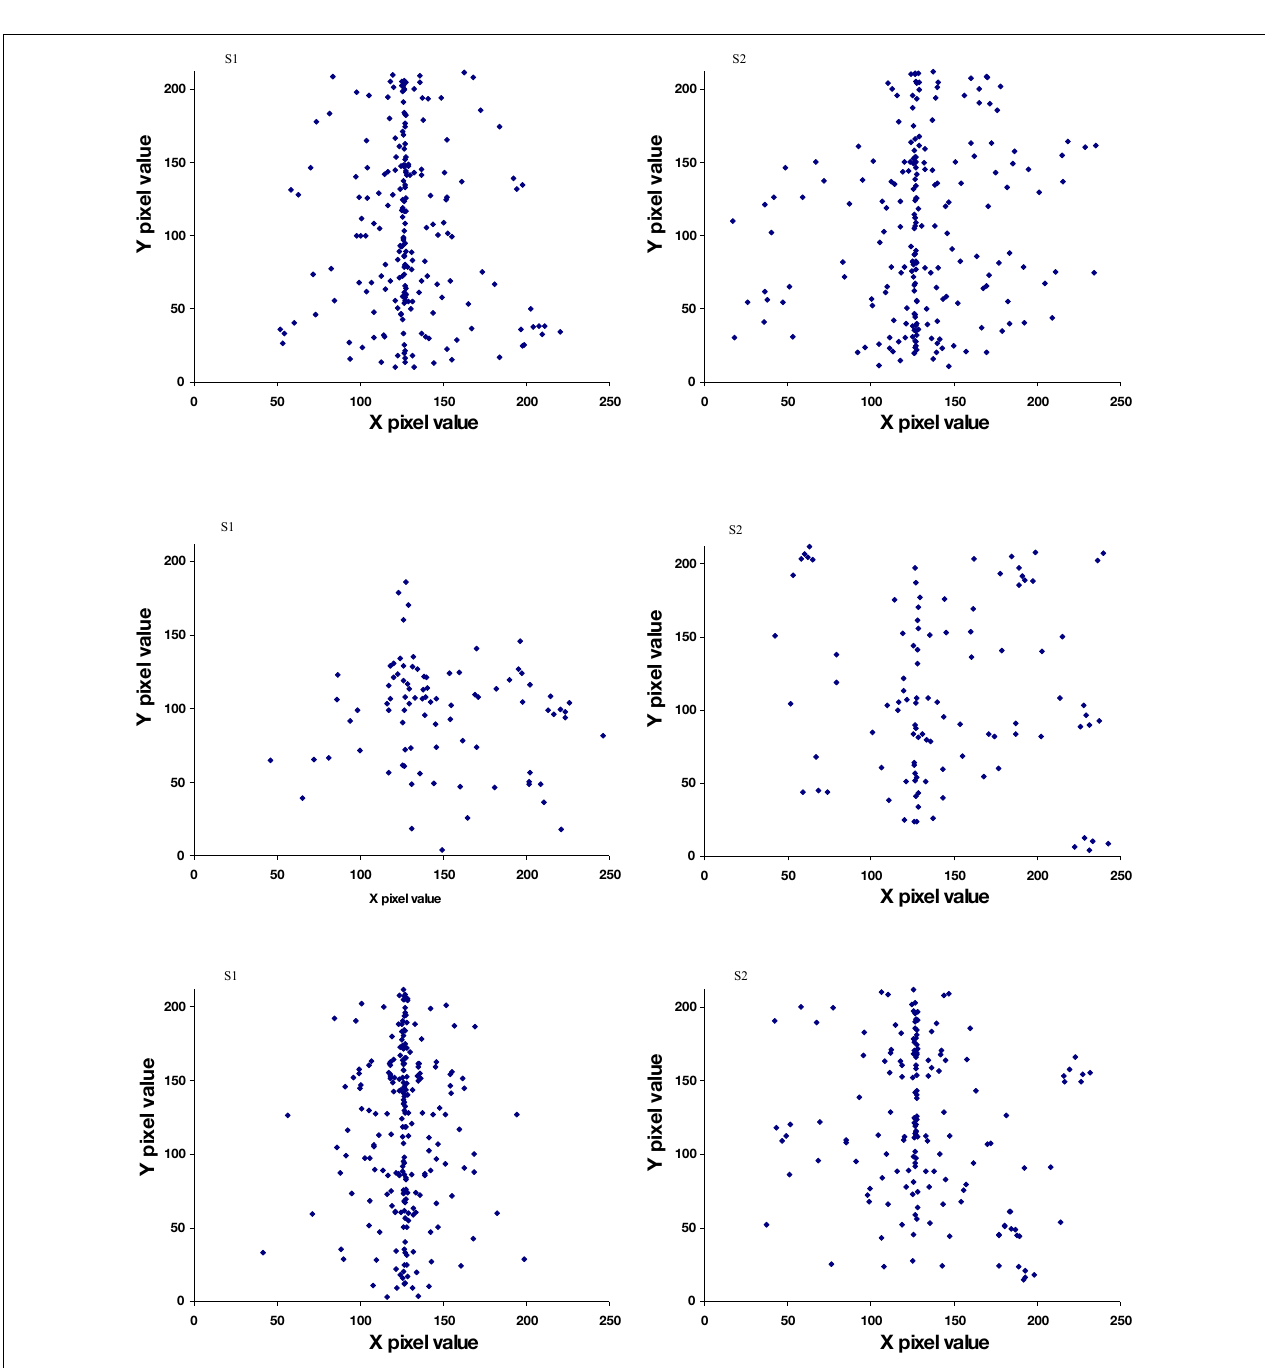
FIGURE 9 | Perceived location of eyes chosen by two observers in images with symmetric luminance variations but random color (top); symmetric color but random luminance (middle); or in nominally equiluminant images